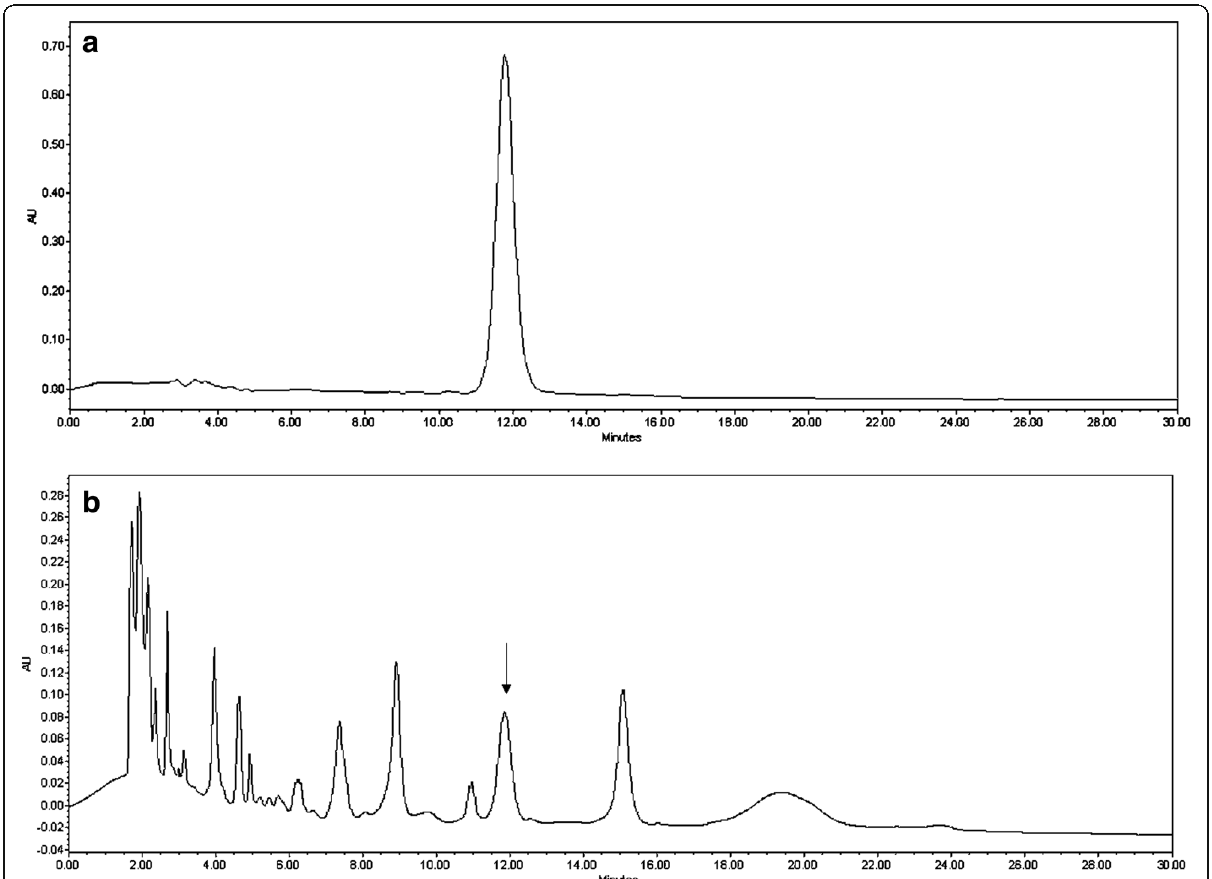
Fig. 1 a ; Representative chromatogram of standard drug naringin; b ; Representative chromatogram of the 50 μ L GFJ injected into HPLC